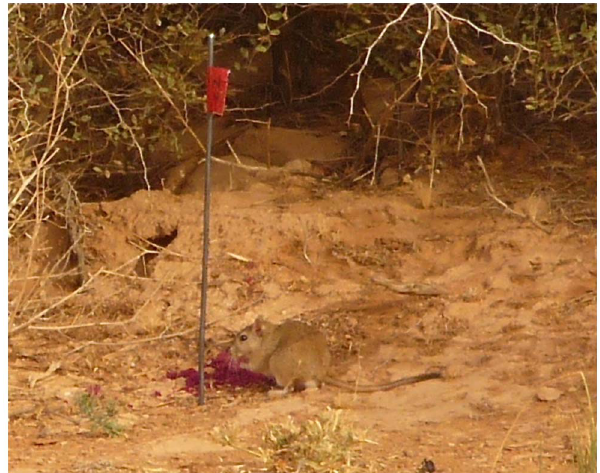
Figure 4. Shaw’s jird feeding on bait that had been placed at a study site.